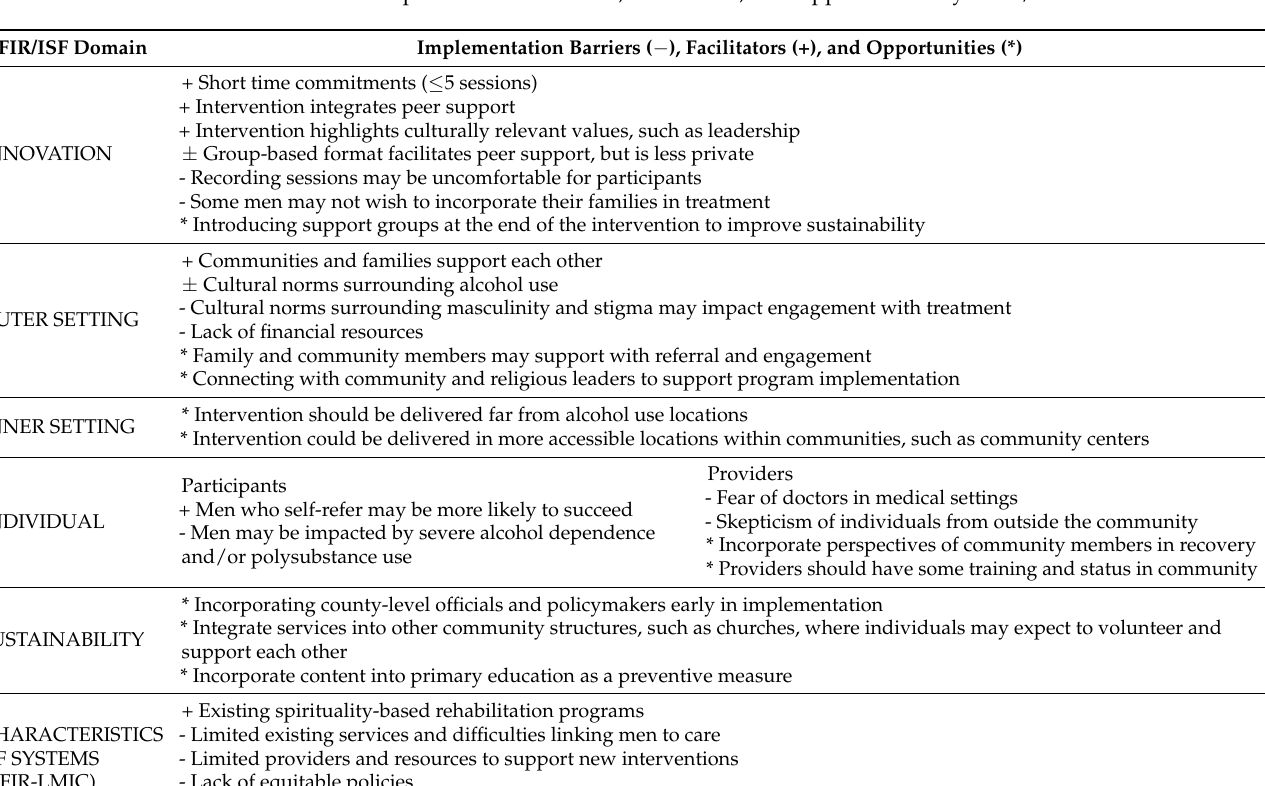
Table 2. Implementation Barriers, Facilitators, and Opportunities by CFIR/ISF